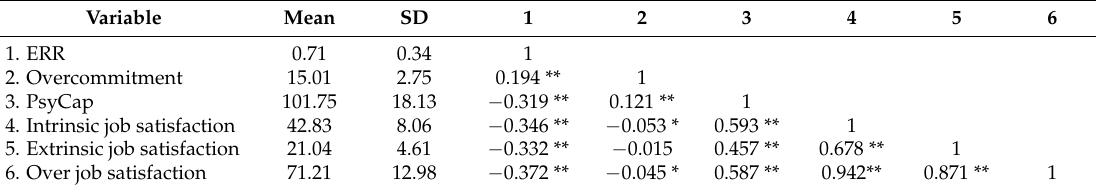
Table 2. Correlation between occupational stress, PsyCap and job